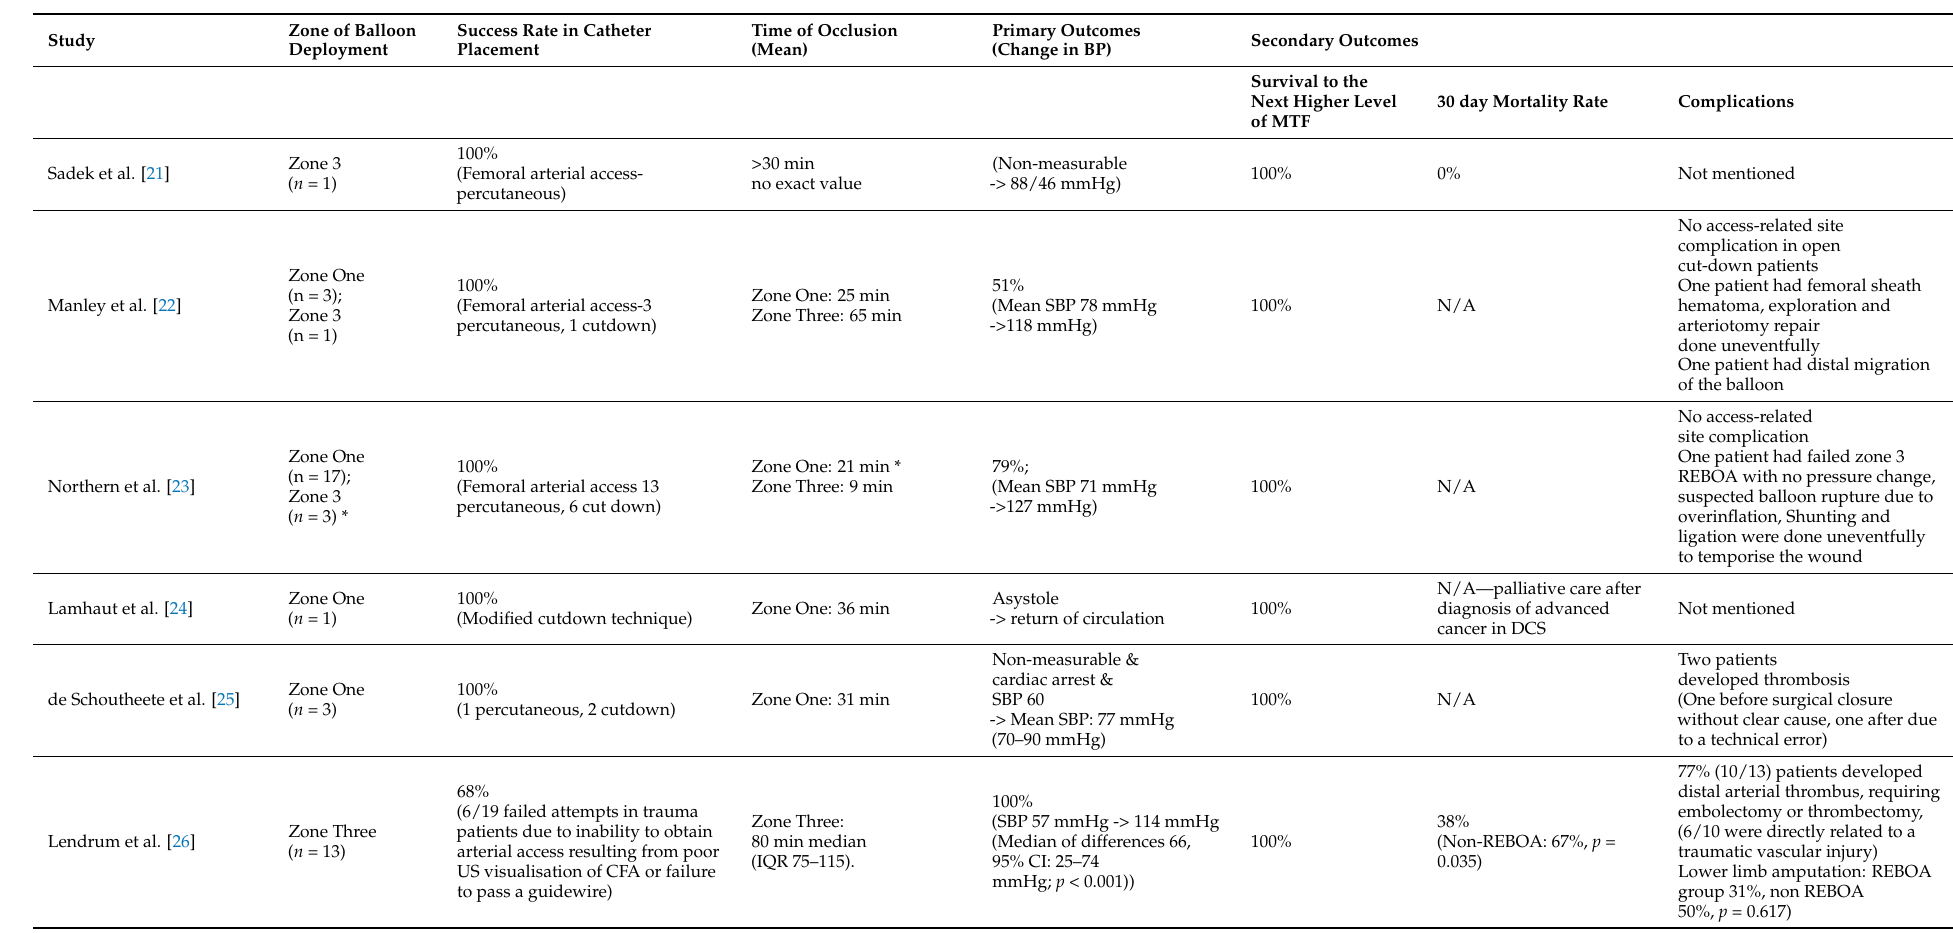
Table 5. Summary of main findings of included